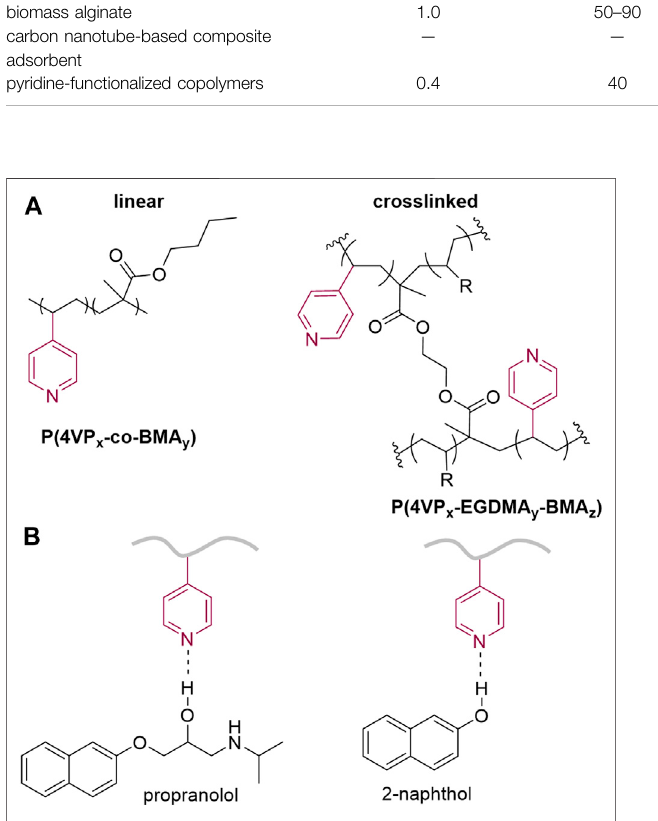
FIGURE 1 | Chemical structures of (A) linear and crosslinked pyridine- functionalized polymers and (B) hydrogen-bonding interactions between contaminants and